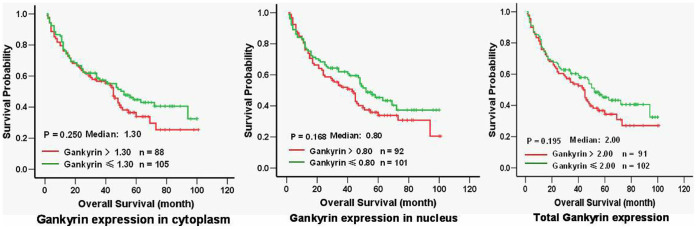
Comparison of the overall survival rates of 193 patients with available follow-up data between the low-Gankyrin and high-Gankyrin groups.